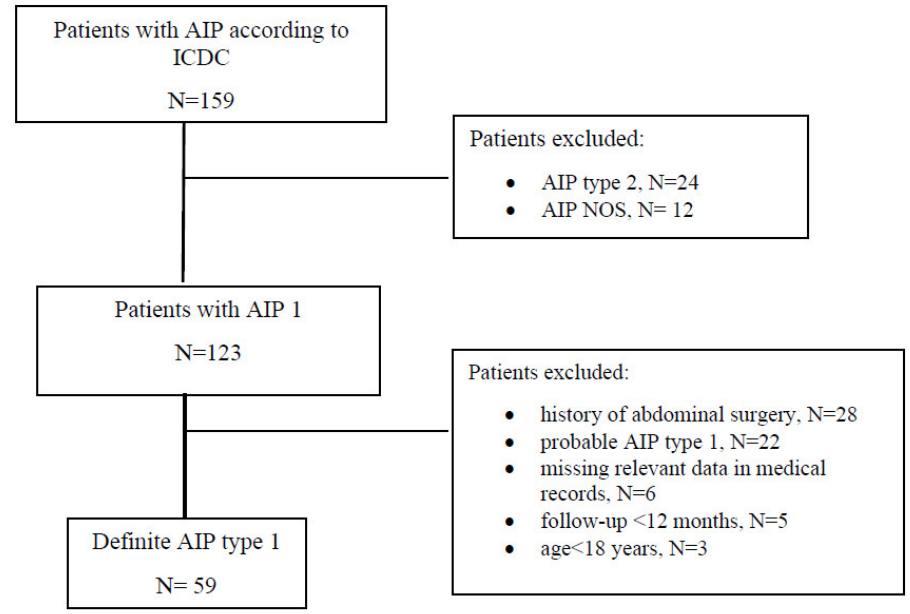
Figure 1. Flow chart of patients. AIP = autoimmune pancreatitis; ICDC = International Consensus Diagnostic Criteria; N = number of patients.